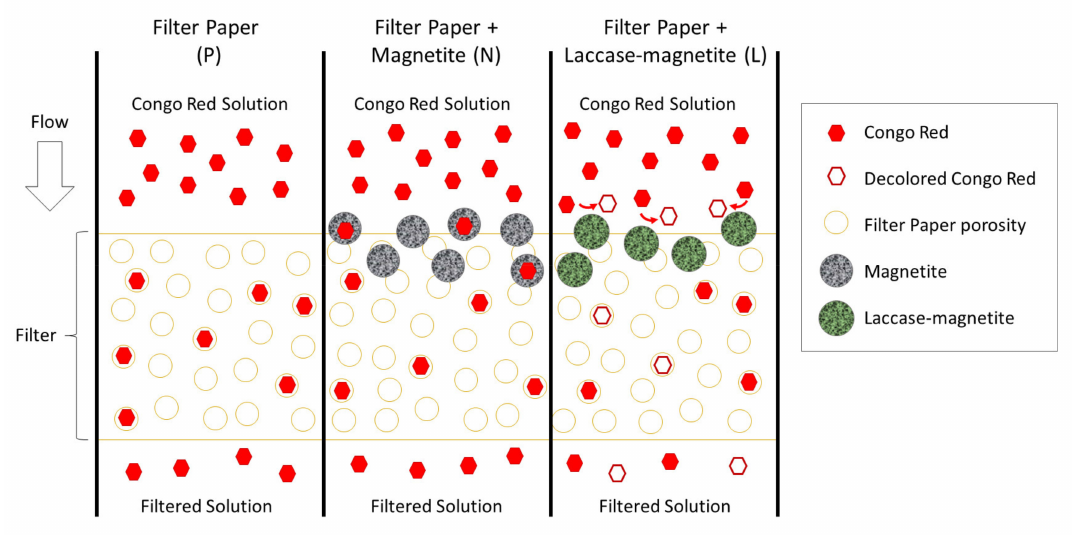
Figure 9. Interaction between the filter material and Congo Red dye molecules diagram.